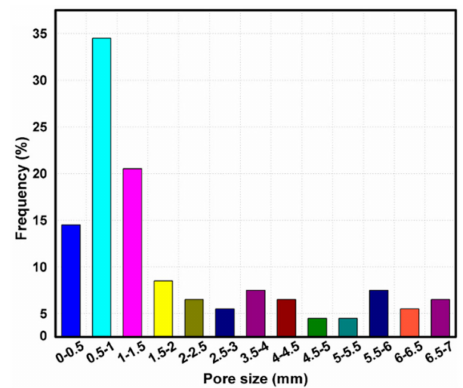
Figure 2. Pore size distribution of Al-SiC hybrid composite foam.